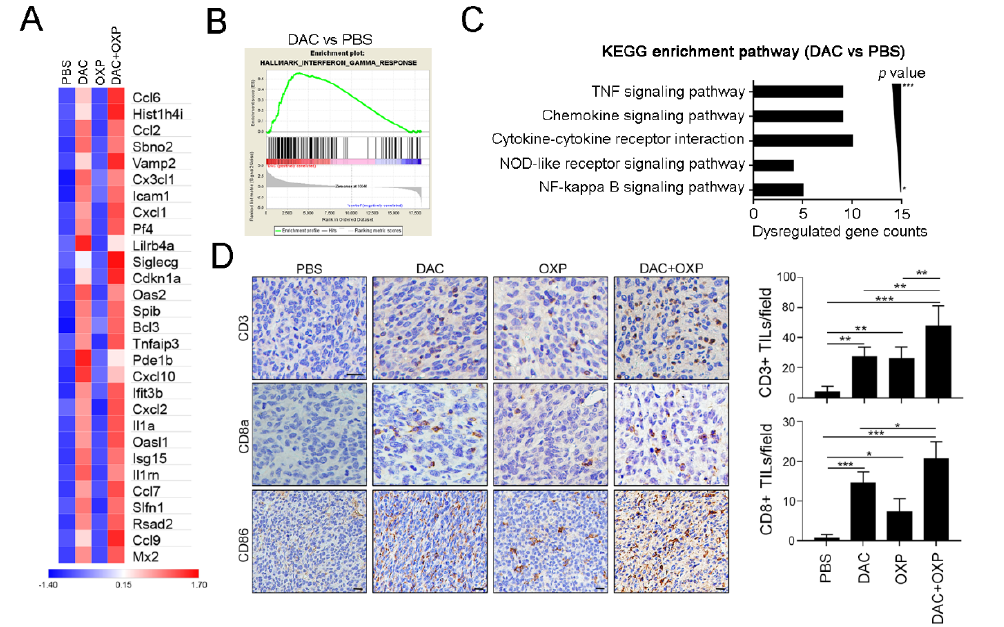
Figure 5. Decitabine remodeled the immunogenicity of the tumor microenvironment in colorectal cancer (CRC) in vivo. ( A ) Resected tumors from representative mice were analyzed by RNA-seq ( n = 2), and the expression of immune-related genes was significantly upregulated by DAC. ( B ) The gene set enrichment analysis (GSEA) plot for the signature “interferon- γ response,” which represents a set of IFN- γ -related genes that exhibited an upregulated expression after treatment with DAC for 5 consecutive days, is shown. ( C ) The immune-related gene numbers were plotted based on KEGG classification, and the p value of each category. ( D ) Resected tumors from representative mice were analyzed for CD3+ intratumoral-infiltrating lymphocytes (TILs), CD8a+ TILs, and CD86 expression by immunohistochemistry ( n = 4). Bar: 10 µ m. The quantification of these results is shown ( n = 4); * p < 0.01, ** p < 0.01 and *** p <